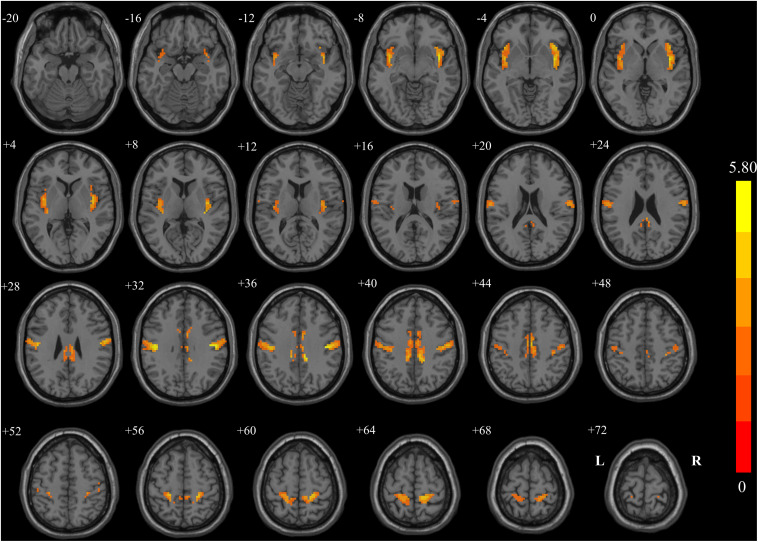
Regions showing significant changes in voxel-mirrored homotopic connectivity (VMHC) between breast cancer (BC) patients and healthy controls (HCs) with two-dimensional structural drawing. Statistical maps of voxel t-values of VMHC between BC and HC. The left side of each image corresponds to the left hemisphere of the brain, yellow denotes higher VMHC values (BC < HC), and the color bar indicates T values from t-tests between groups.